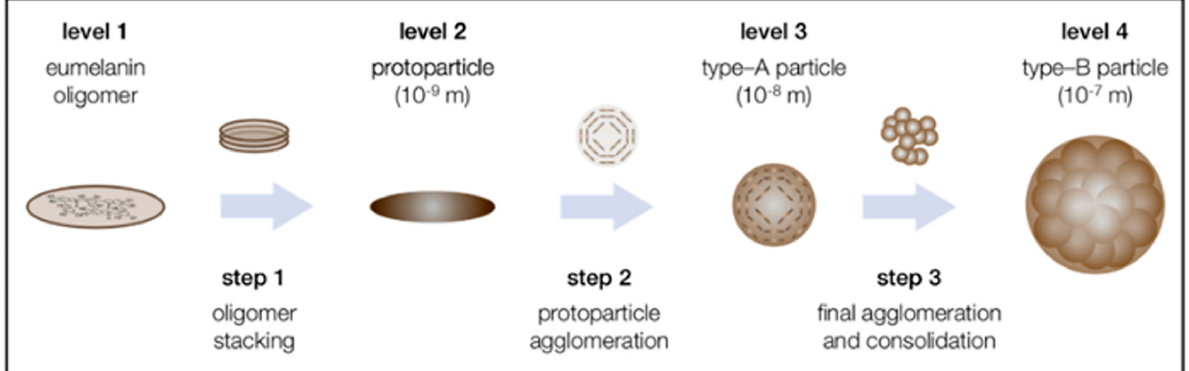
Figure 2. The proposed three-step mechanism for the supramolecular buildup of eumelanin based on the state of the literature and the presented results. Adapted from [56] with minor modifications.